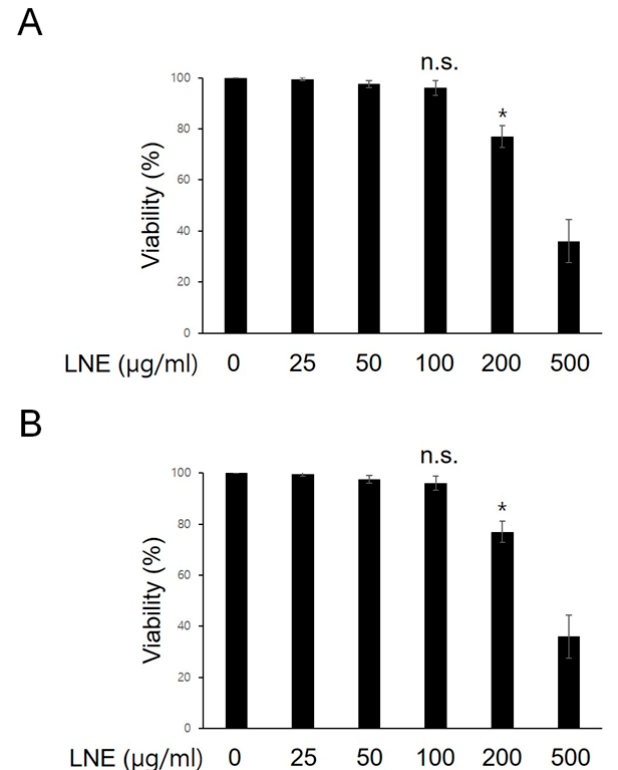
Figure 1. Determination of Laurus nobilis ( L. nobilis ) extract (LNE) concentrations in Bone